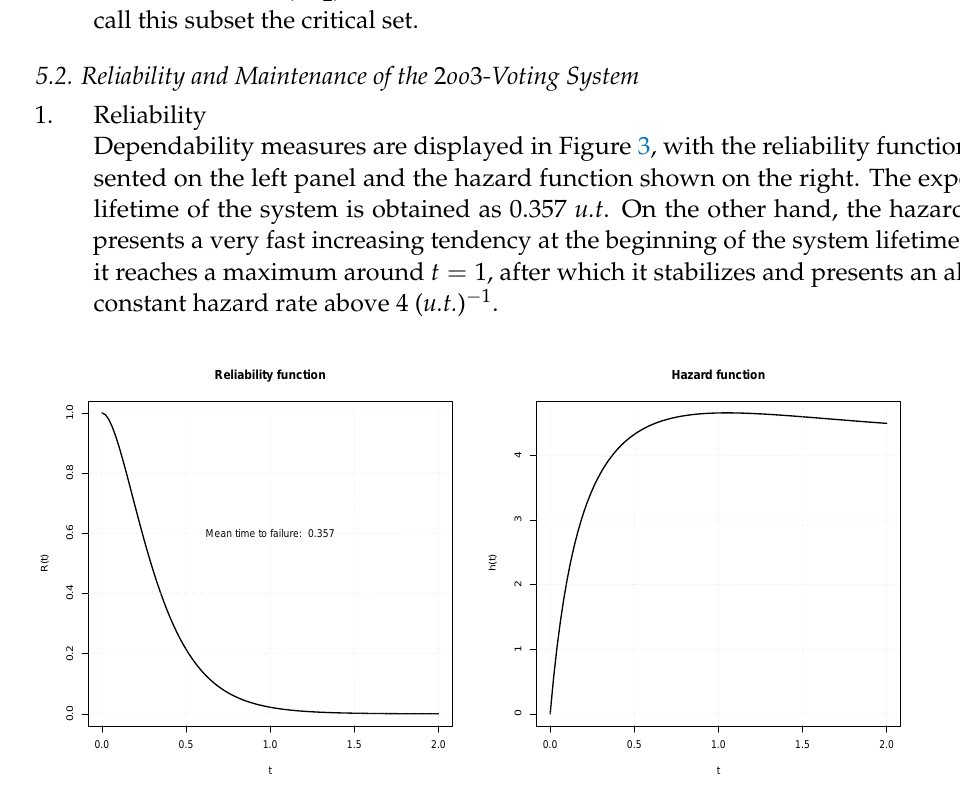
Figure 3. Voting system. ( Left panel ): Reliability function with mean time to failure. ( Right panel ): Hazard